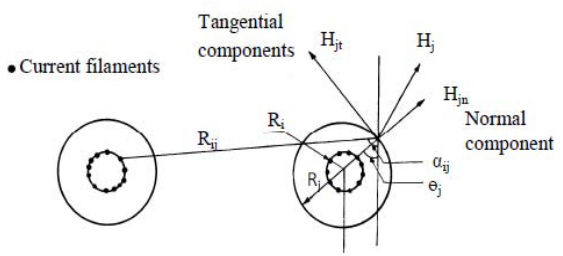
Figure 2: Normal and tangential field components at a point on the sub-conductor